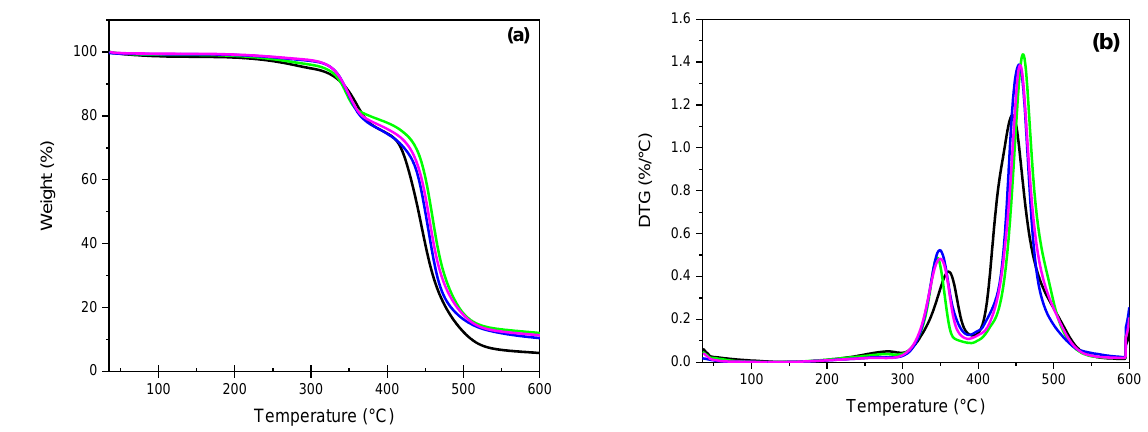
Figure 5. Thermal gravimetric behaviour of recast Nafion and hybrid membranes. Recast Nafion membrane (black) and Nafion membrane with 5, 10, and 15 wt% tungsten oxide (green, blue, and purple, respectively), ( a ) TGA and DTG ( b ).